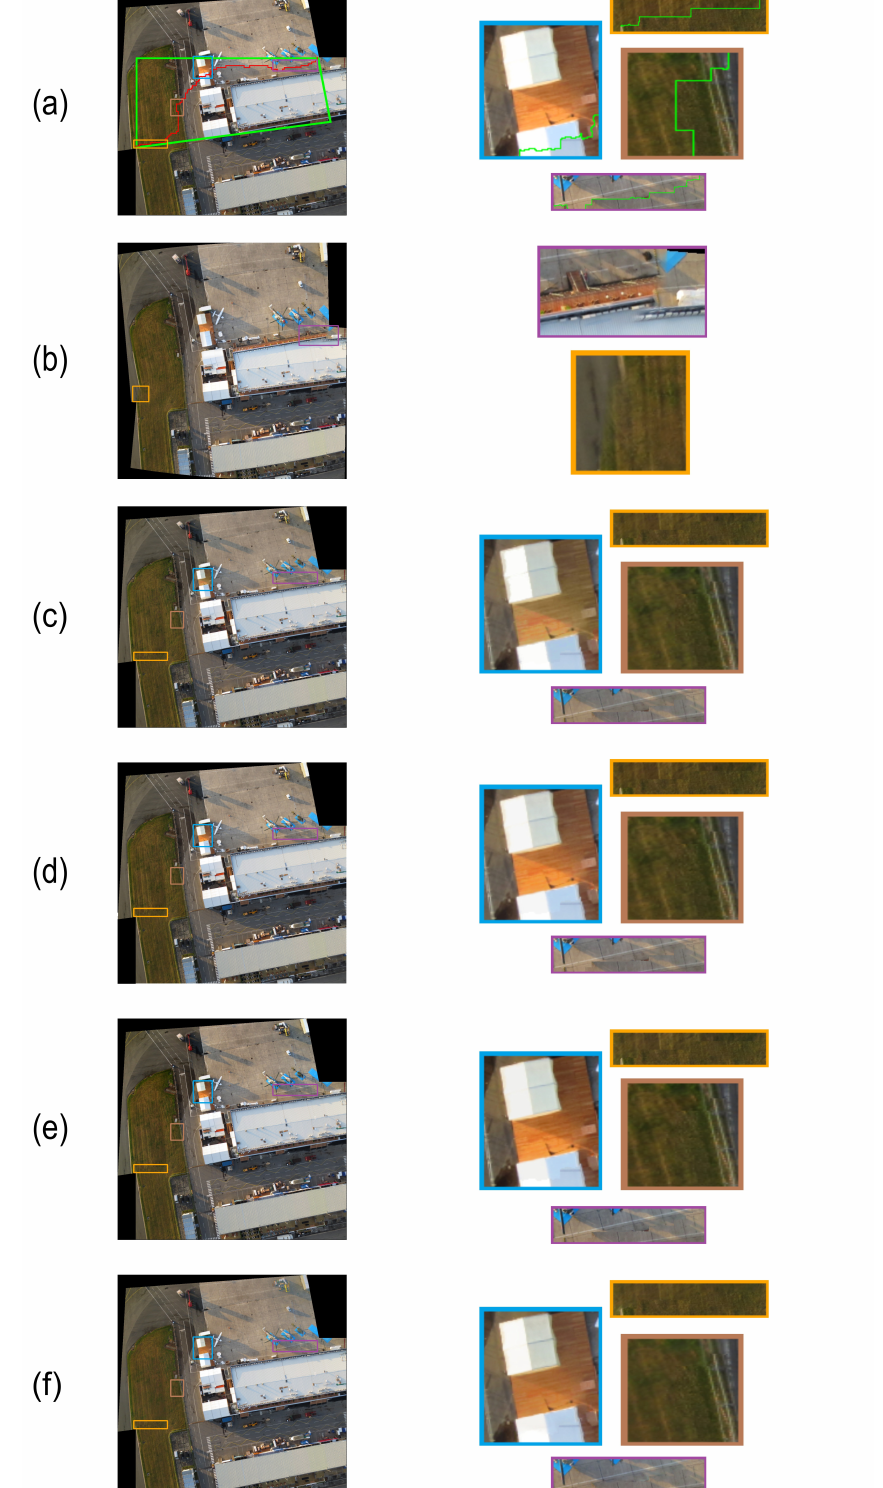
Figure 11. The perceptual quality merit of our method for the fourth testing stitched image taken from S 2 under − 25% brightness update. ( a ) The testing stitched image and the amplified sub-images near the stitching line. ( b ) The MBB method [18]. ( c ) The HM-based method [19]. ( d ) The GP-based method [21]. ( e ) The GBJI-based method [23]. ( f ) Our